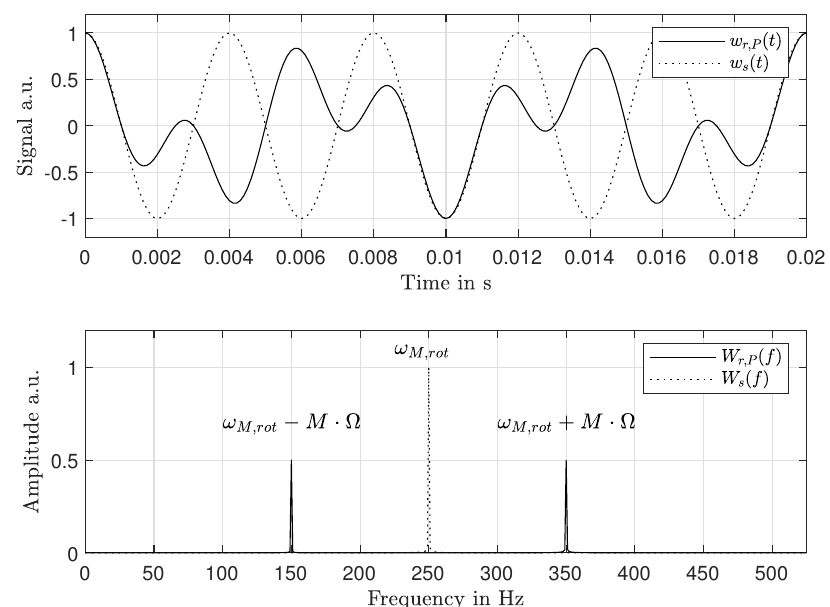
Figure 2. Simulation of the rotating frame (dashed) and stationary frame measurement (solid) at the outer radius of the disk, which vibrates with its first diametrical mode ( M = 1) at 250 Hz and rotates with Ω = 100 Hz. P was set to a location of maximum